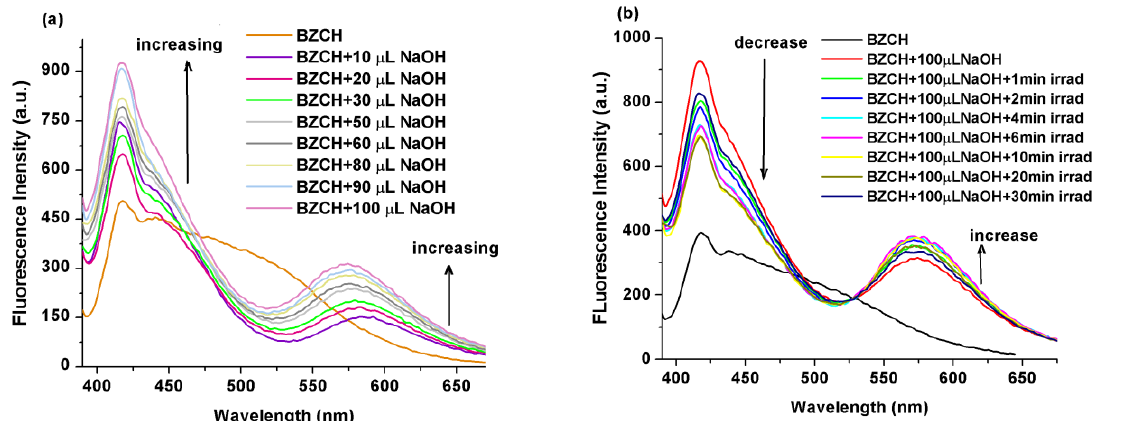
Figure 5. Changes in the emission spectra of BZCH in DMSO solutions upon the gradual addition of NaOH (0.1 N) ( a ) followed by irradiation with 365 nm UV light for various time intervals ( b ). The corresponding absorption maximum was used as the excitation wavelength.